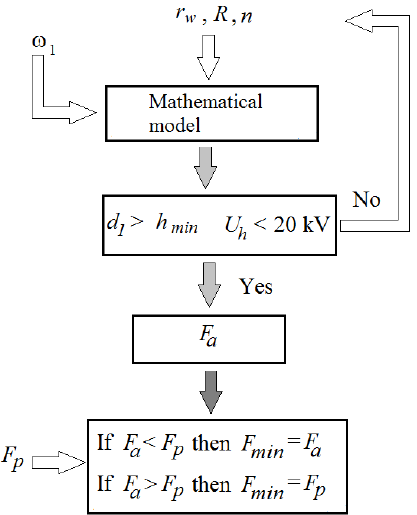
Figure 19. Algorithm of calculations carried out in one calculation